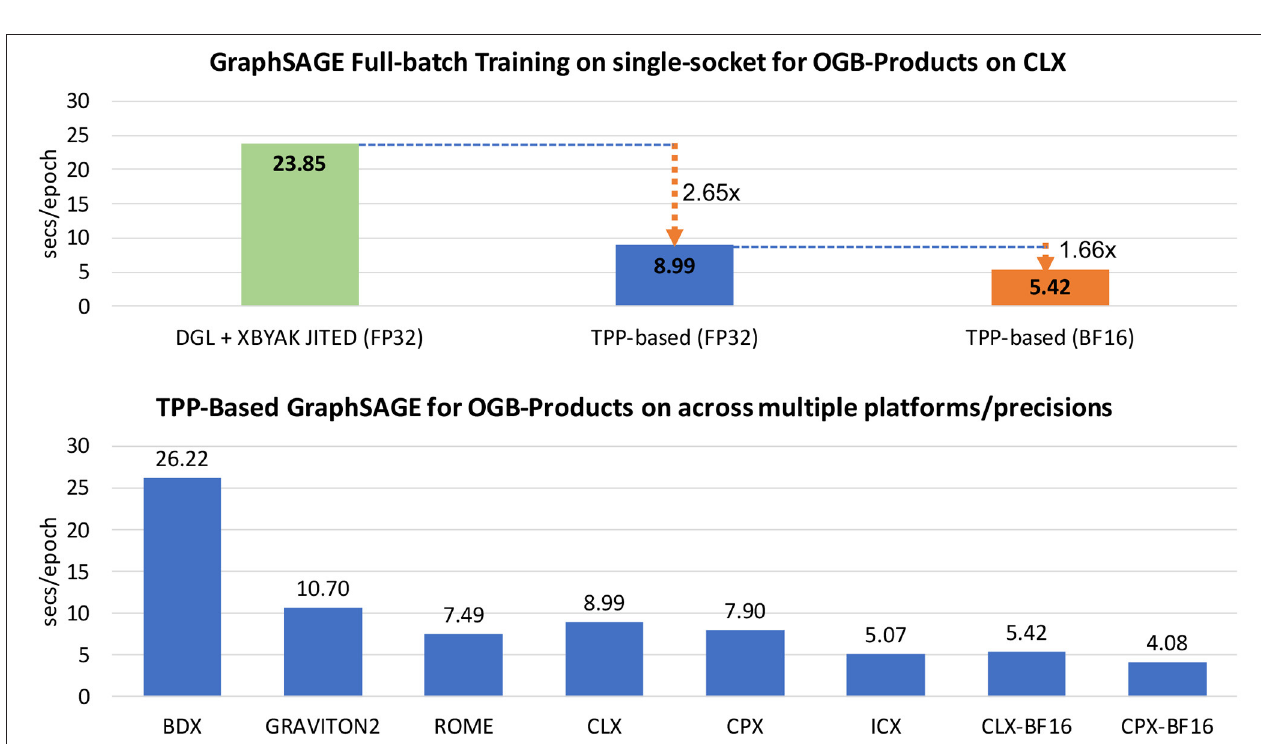
FIGURE 28 | GNN performance of GaphSAGE Full-batch training for OGB-Products.